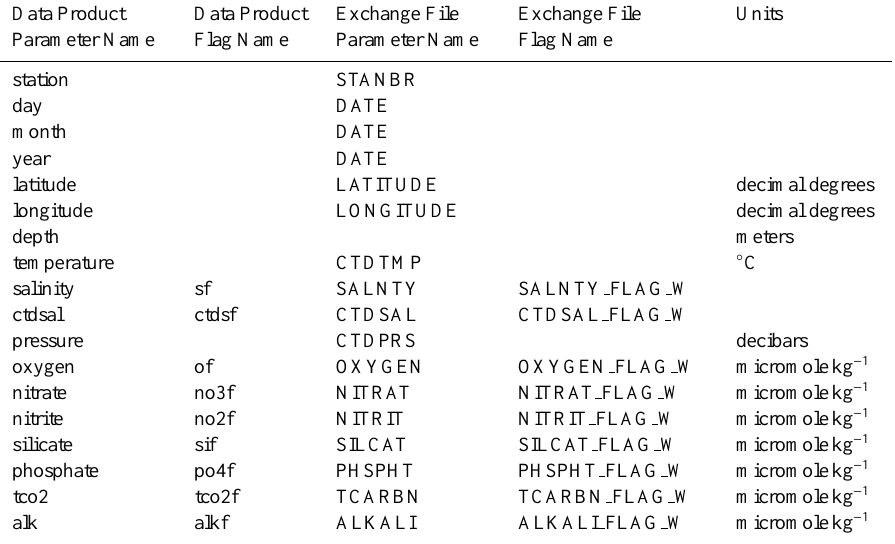
Table of parameters directly relevant for this overview. For a list of all properties in the CARINA data base see Key et al. (2009).